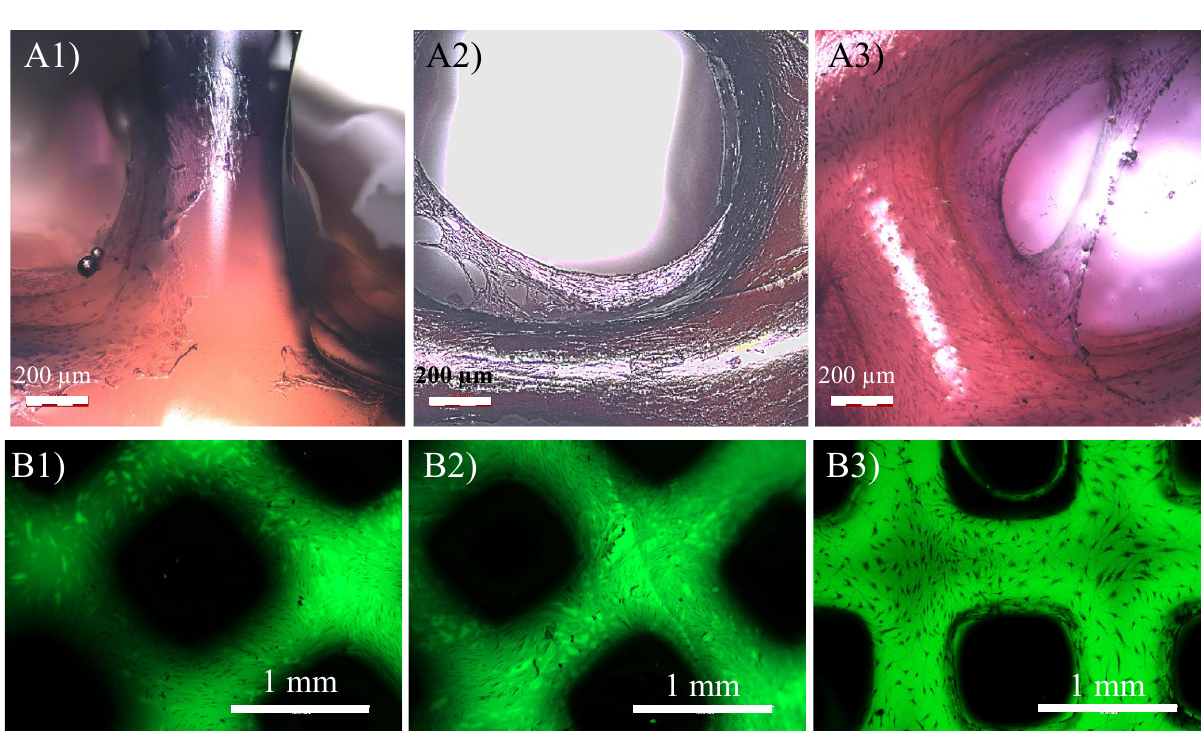
Figure 7. ( A1 – A3 ) Chondrocyte attachment, growth and ECM secretion on gelatin/elastin/sodium hyaluronate scaffolds after ( A1 ) 7, ( A2 ) 14 and ( A3) 21 days post-seeding. The samples were stained with Eosin/ Hematoxylin using standard histology protocols and the images were taken using a 3D confocal laser scanning microscope (label-free). ( B1 – B3 ) Fluorescence images of the chondrocytes growing on the gelatin/elastin/ sodium-hyaluronate construct after ( B1 ) 7, ( B2 ) 14 and ( B3 ) 21